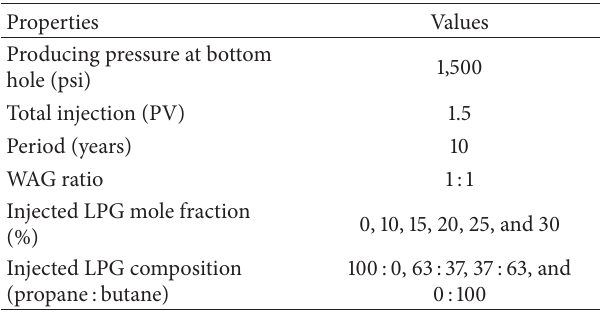
Table 5: Operating conditions and injection design parameters. Properties